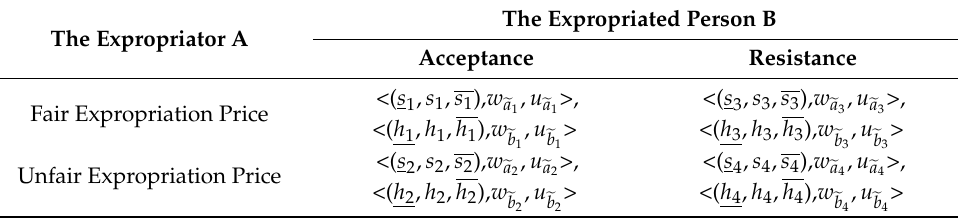
Table 1. Profit-seeking fair fuzzy equilibrium evaluation